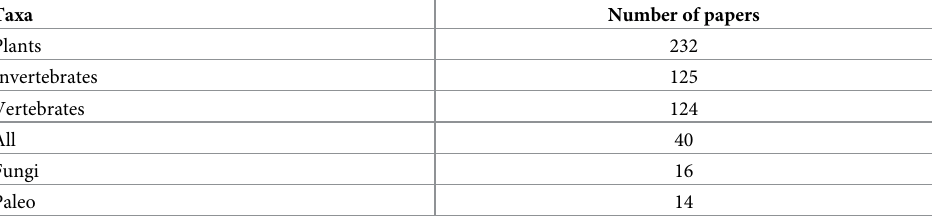
Table 3. Total number of papers from dataset (501) addressing the major taxonomic groups and paleontological